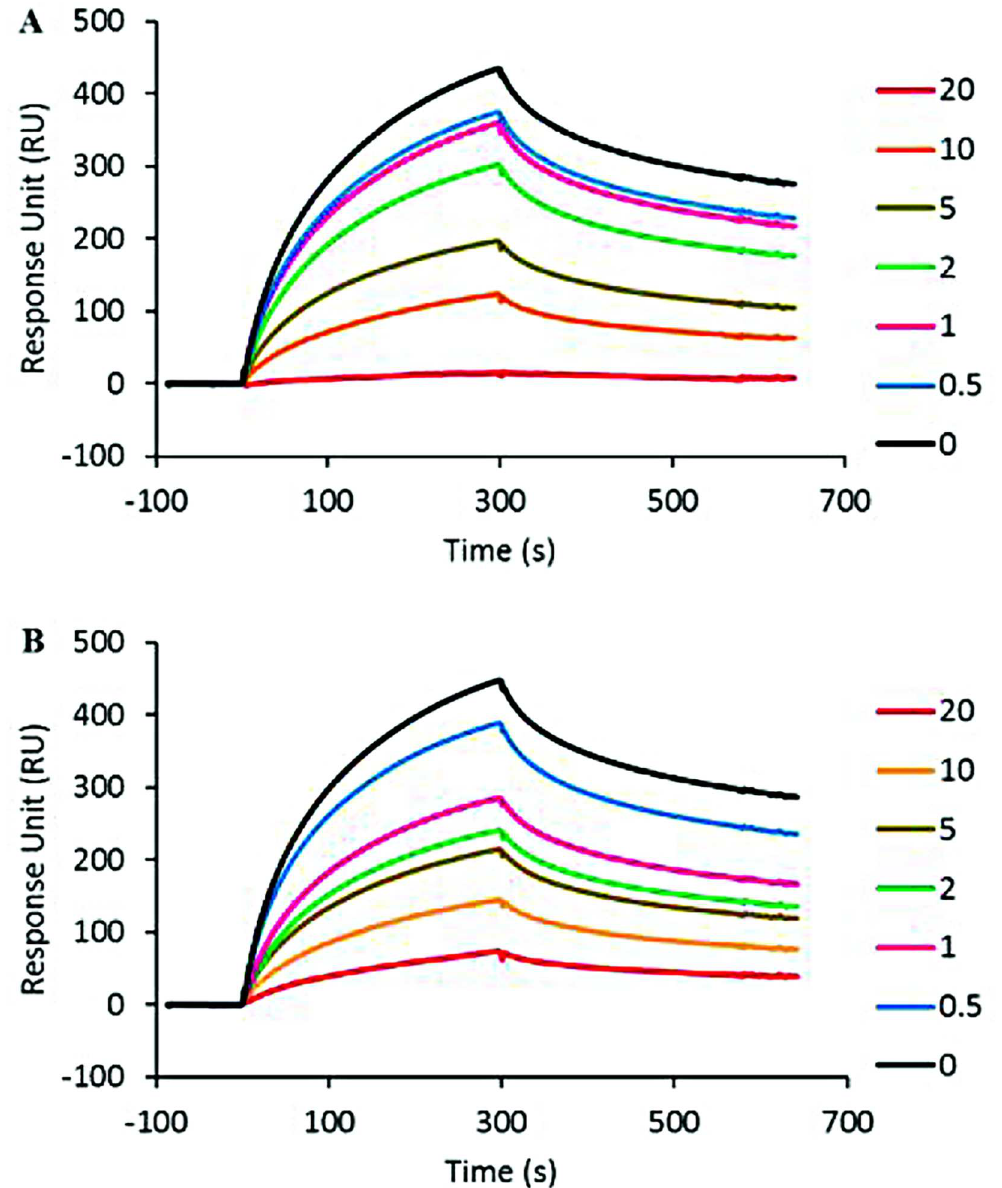
Fig 3. IND02 and IND02-trimer inhibition of gp120 binding to immobilized HS. HIV-1 gp120 (MN) was injected over the immobilized HS surface at 10 μ l/min in the presence or absence of IND02 (A) or IND02-trimer (B) at the indicatedconcentrations (in μ M). The specific bindingresponsesin resonance unit (RU) was recorded as a function of time (s), and after each injectionthe surface was regenerated by a short pulse of 0.05% SDS and 2M